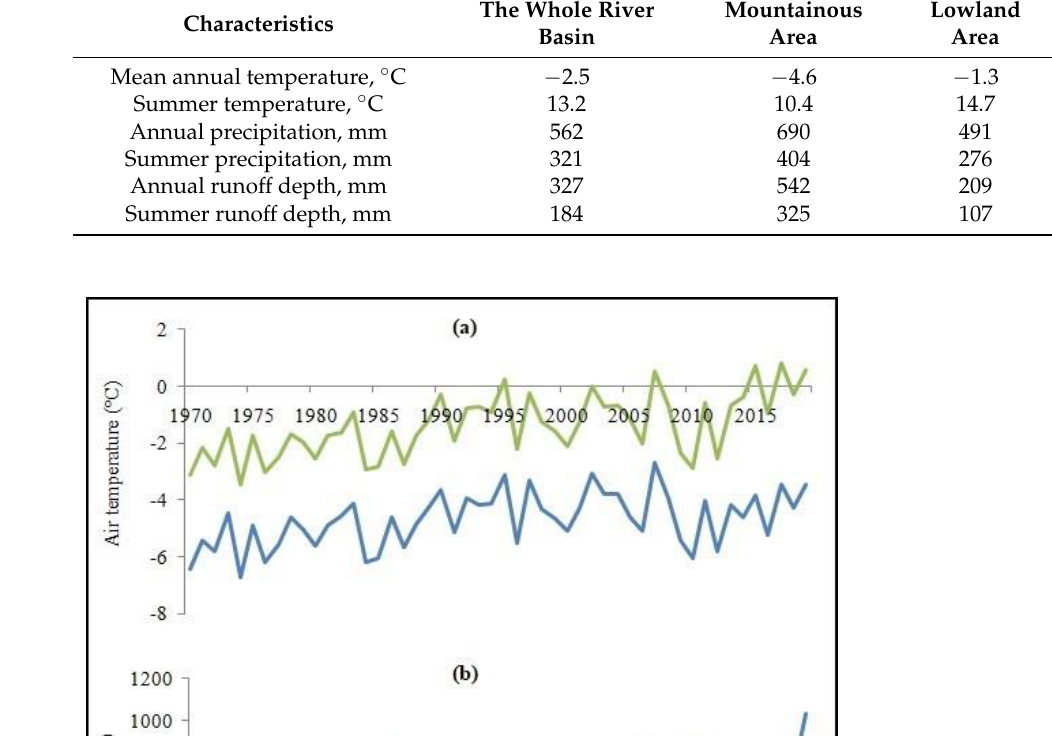
Figure 2. Soil map ( a ) and landuse/landcover map ( b ) of the Iya River basin, according to Harmonized World Soil Data- base and Global Land Cover Characterization.